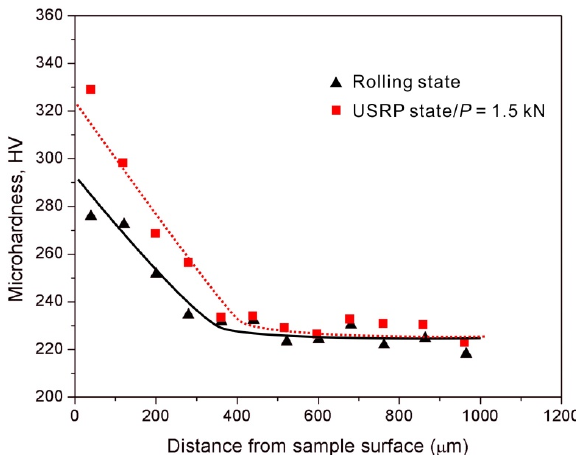
Figure 11. Microhardness distribution along the cross-section of rolling and USRP-treated specimens with a static load P of 1.5 kN .